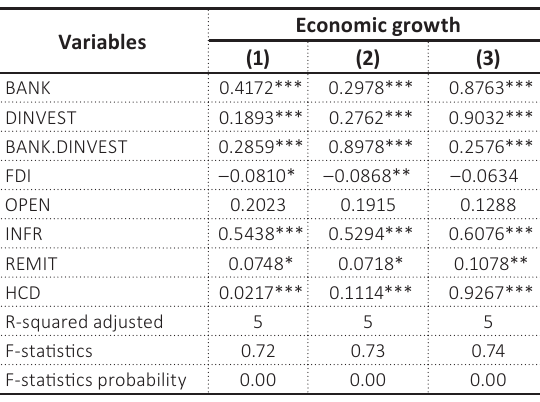
Table 5. Pooled OLS